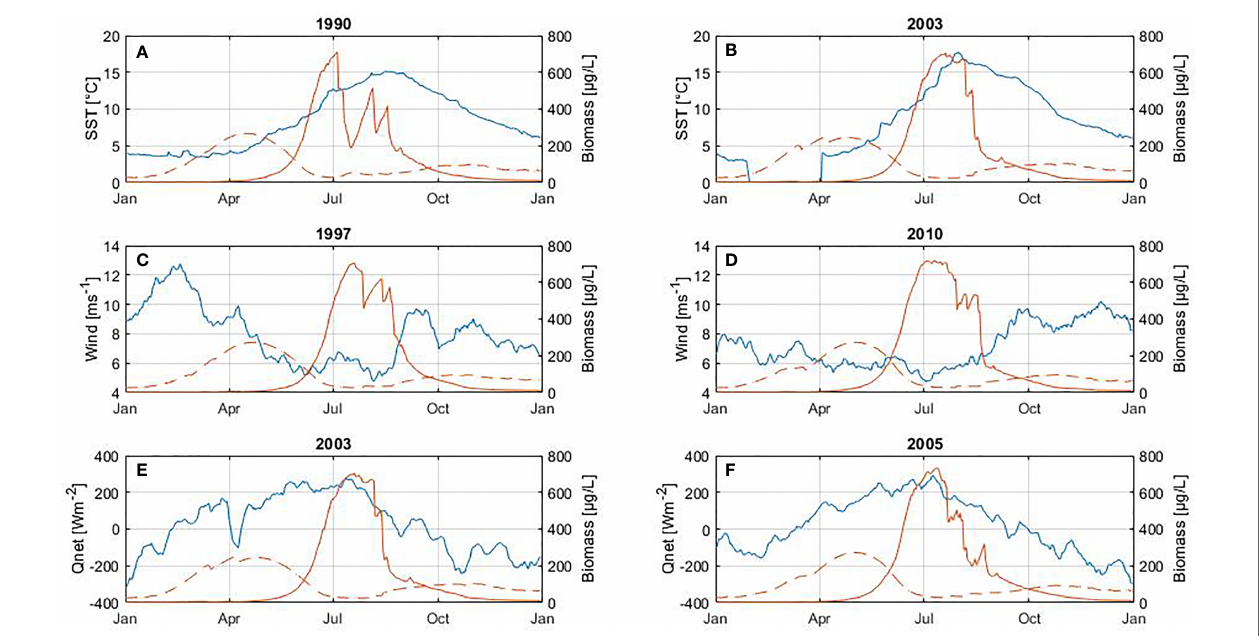
FIGURE 8 | Influence of SST (A, B) , wind (C, D) and net heat flux (E, F) on diatom biomass (between February and May). At the top of each plot is shown the year with the highest positive anomalies (left panel) and negative anomalies (right panel) for each variable. The blue line corresponds to the variable (left axes) and the red line to biomass (right axes) of diatoms (dashed line) and cyanobacteria (solid line). The cyanobacteria bloom is included only to illustrate its inter-annual cycle.